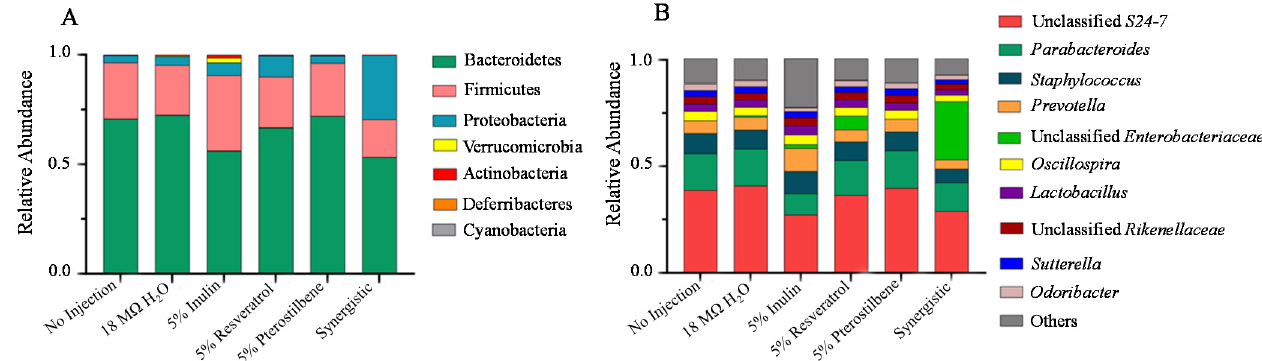
Figure 4. Compositional differences of gut microbiota in response to the intra-amniotic administration of stilbenes. The graph represents the percentage of the relative abundance of a specific phylum in relation to the other phyla identified in the same treatment group. ( A ) Phylum level differences measured upon hatching. ( B ) Genus level differences measured on the day of hatching (day 21).